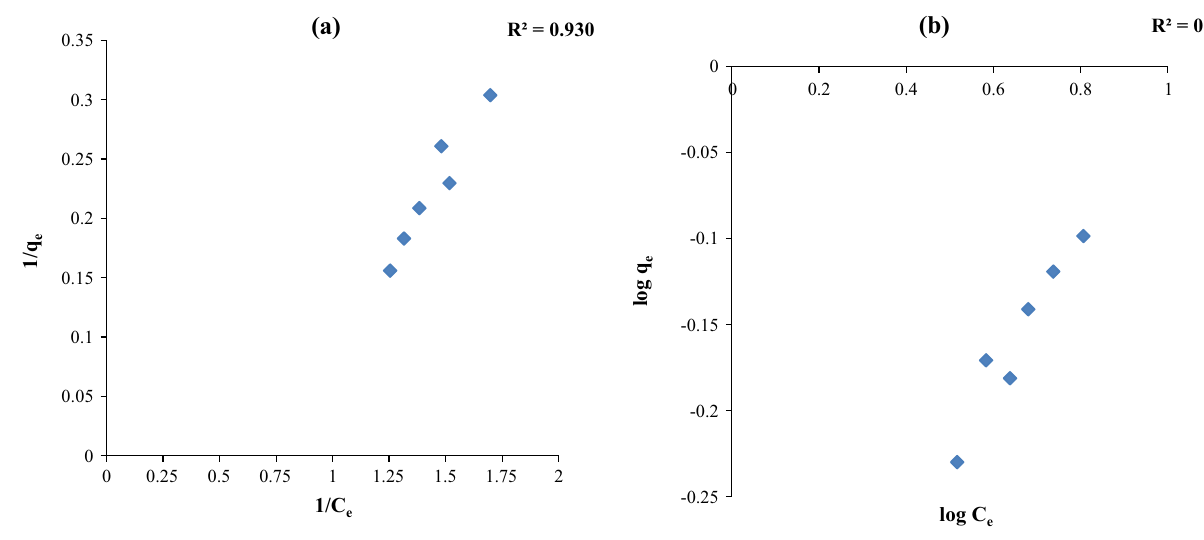
Fig. 8 a Langmuir and b Freundlich isotherm models for adsorption of Pb 2+ on bagasse biochar